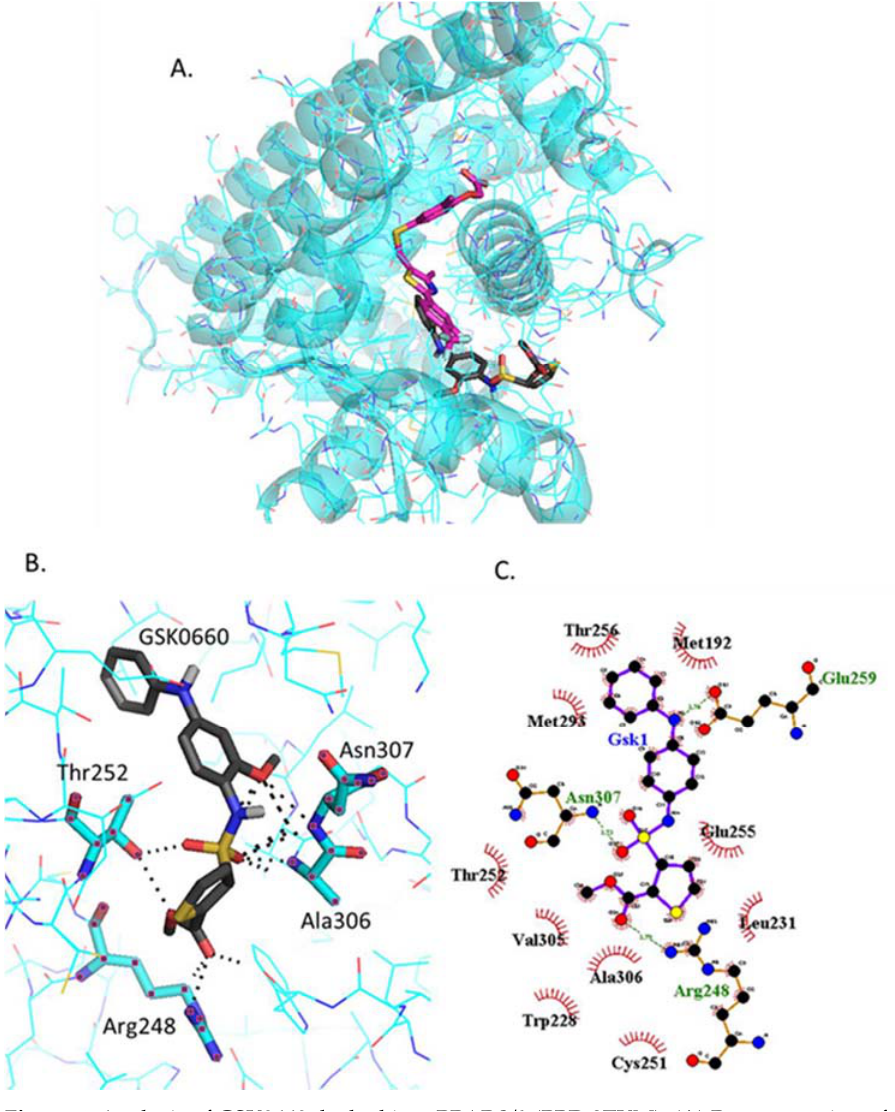
Figure 6. Analysis of GSK0660 docked into PPAR β / δ (PBD:3TKM). ( A ) Representation of the most stable GSK0660 docking conformation (grey) compared to the GW0742 of the crystal structure (pink). ( B ) 3D detail of the amino acids forming polar bindings with GSK0660 calculated by Pymol. Color coding of atoms: red O, Blue N, mustard S, white F, pink C of GW0742 from the crystal structure, grey C of GSK0660 docked into the crystal structure, cyan C from PPAR β / δ . ( C ) Schematic 2D representation of the interaction between PPAR β / δ LBD and GSK0660 calculated using Ligplot+. The green dashed lines indicate polar interactions and the red spoked arcs indicate hydrophobic interactions. Colour coding of atoms: red O, blue N, yellow S, green F, black C.